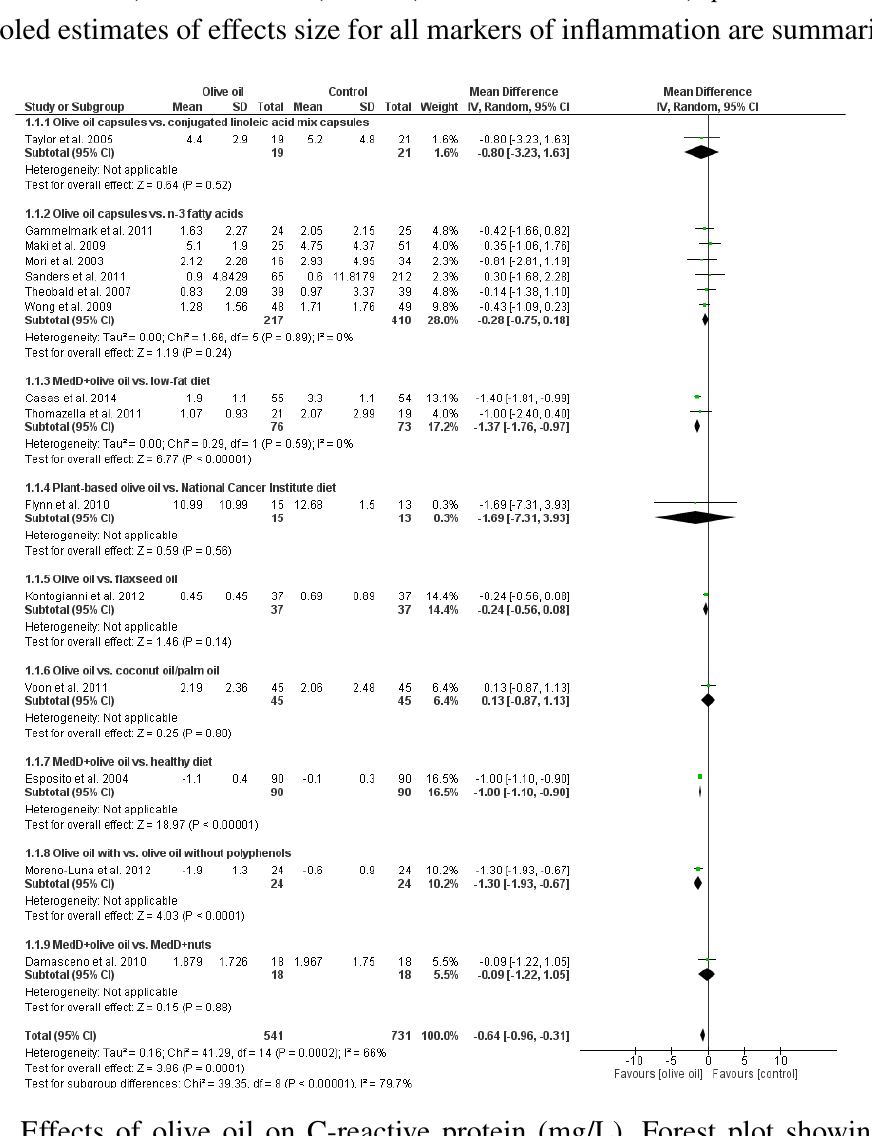
Figure 3. Effects of olive oil on C-reactive protein (mg/L). Forest plot showing pooled mean differences with 95% confidence intervals (CI) for 14 randomized controlled diets. For each study, the shaded square represents the point estimate of the intervention effect. The horizontal line joins the lower and upper limits of the 95% CI of these effects. The area of the shaded square reflects the relative weight of the study in the respective meta-analysis. The diamond at the bottom of the graph represents the pooled MD with the 95% CI for all study groups. MedD = Mediterranean diet.